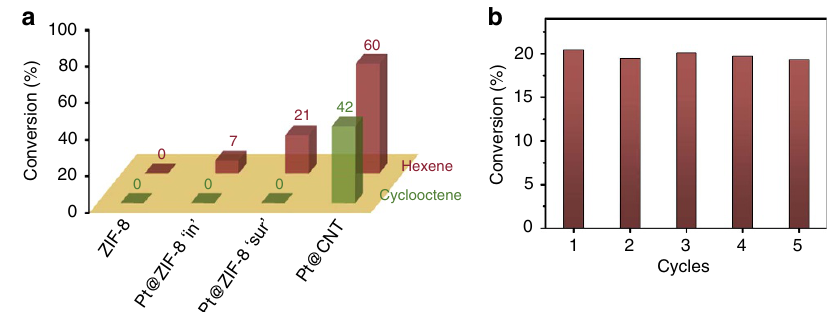
Figure 6 | Catalytic properties of ZnO@Pt@ZIF-8 composites for olefin hydrogenation. ( a ) Size-selective hydrogenation of n-hexene and cyclooctene catalysed by ZnO@Pt@ZIF-8 composite (3.3nm Pt NPs with content of 0.9%); ( b ) the reusability of Pt@ZIF-8-‘sur’ as catalysts for the hydrogenation of hexene for five consecutive runs. Reaction conditions: 0.01g of catalyst, 0.1ml of substrate, 3ml of ethyl acetate, 1 atm of hydrogen, 35 (cid:2) C, reaction time of 12h. Pure ZIF-8 and Pt@CNT were used